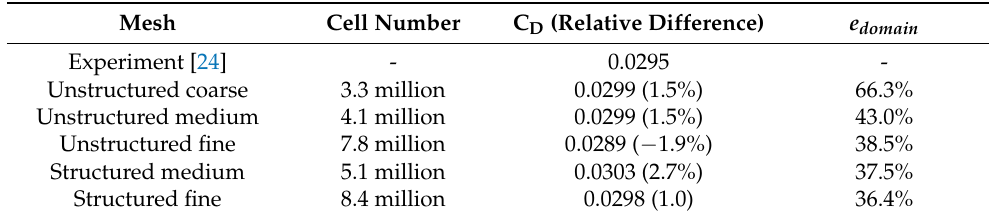
Table 5. Mesh size study presented by the drag coefficient and the power imbalance error of the computational